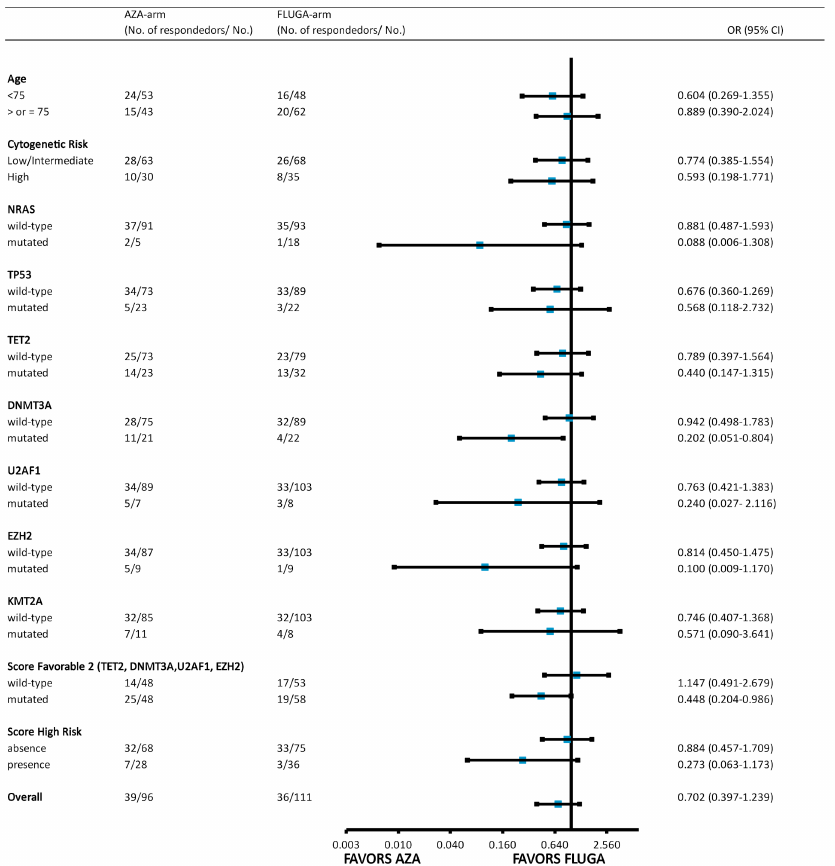
Figure 1. Subgroup analysis of responders to treatment via biological and genomic characteristics. OR: odds ratio, cytogenetic risk: low–intermediate vs. high risk as per ELN 2017 classification; high risk score was defined by the presence of mutated NRAS or TP53 . A score predicting an AZA response was defined by the presence of mutated EZH2 , U2AF1 , DNMT3A, or TET2 genes. Patients with baseline mutations in DNMT3A (odds ratio (OR) 0.20, p = 0.023) or a score predicting AZA response (OR 0.448, p = 0.046) could benefit from